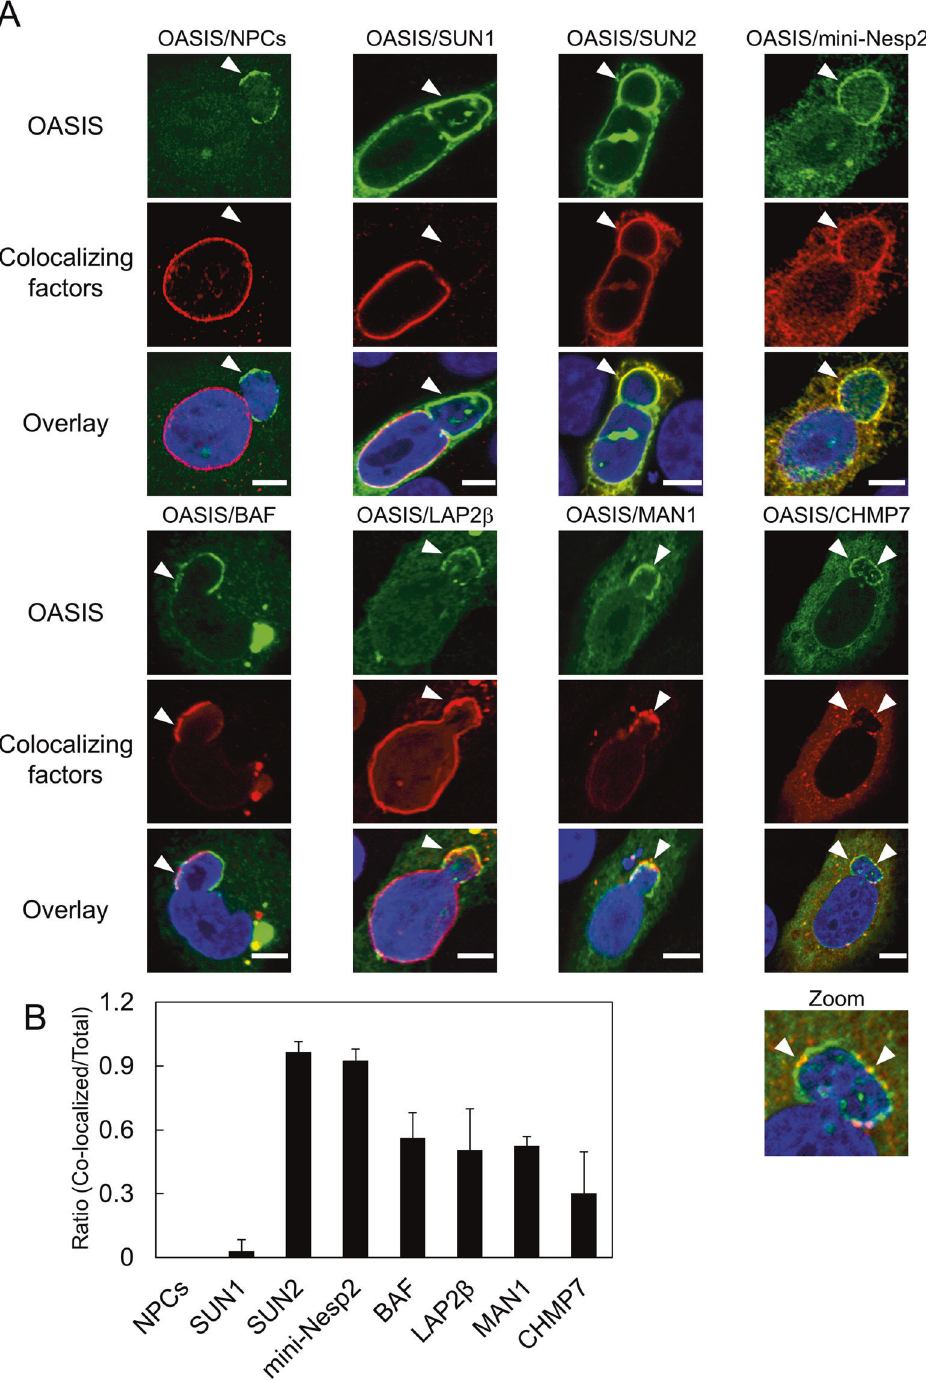
Fig. 5 Exploring factors that colocalize with OASIS at damaged NE. A Immuno fl uorescent staining analysis of indicated factors with Flag- OASIS in shLMNB1 cells. Arrowheads indicate the nuclear blebs where OASIS accumulates. The following antibodies were used to visualize the indicated factors. NPCs: mAb414, a monoclonal antibody that recognizes multiple components of NPCs. SUN1 and SUN2: anti-Myc antibody, mini-Nesp2: anti-Nesprin-2 antibody. GFP-BAF, GFP-MAN1, and GFP-CHMP7: anti-GFP. LAP2 β -GFP: anti-LAP2 β . B Quanti fi cation of the ratio of colocalization of indicated factors with OASIS at the nuclear blebs. Bars and error bars represent the mean values and SD from at least three independent experiments. n = 23 NPCs, n = 32 SUN1, n = 32 SUN2, n = 27 mini-Nesp2, n = 25 BAF, n = 28 LAP2 β , n = 31 MAN1, n = 30 CHMP7. Scale bars: 5 μ m. with SUN2 and Nespirn-2 in the response to mechanical stress. Our data demonstrated that NPCs and SUN1 are depleted from Our results further revealed that BAF, LEM domain proteins, and the nuclear blebs where OASIS accumulates, whereas SUN2 and ESCRT III component CHMP7 colocalize with OASIS at the nuclear Nesprin-2 colocalize with OASIS at those nuclear blebs (Fig. 5A, B). blebs (Fig. 5B). Interestingly, the colocalization of NE repair factors These results suggest that OASIS could play a certain role together Cell Death Discovery (2021)